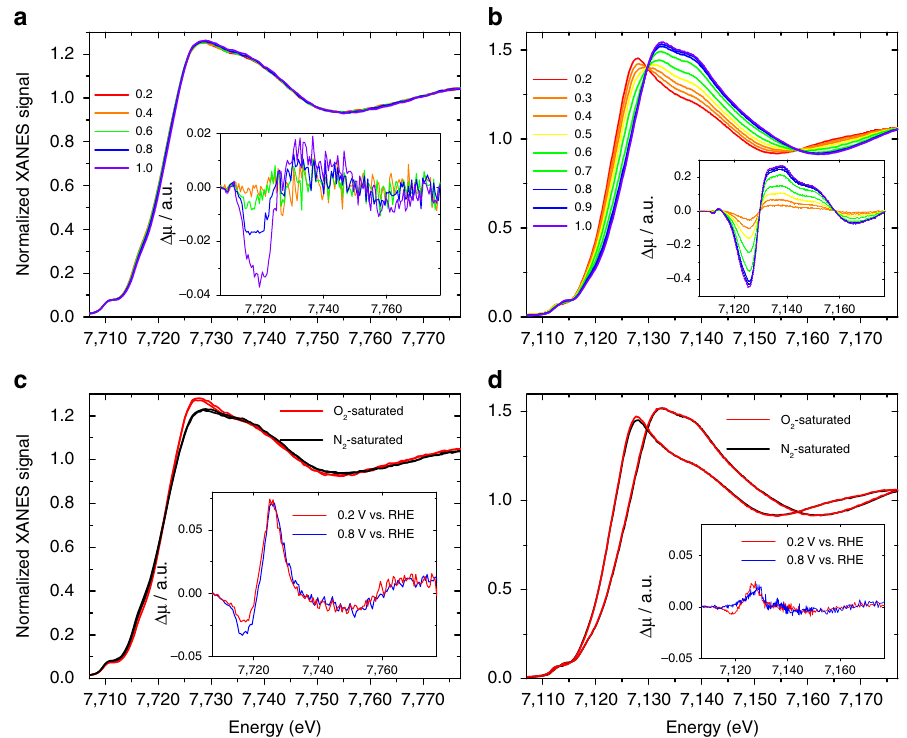
Fig. 4 Operando XANES spectra. Taken in 0.5 M H 2 SO 4 for Co 0.5 (left) and Fe 0.5 (right). The spectra were measured as a function of the electrochemical potential in N 2 -saturated electrolyte for a Co 0.5 and b Fe 0.5 (legend for potentials is in V vs RHE) and measured as a function of the saturating gas (O 2 or N 2 ) at either 0.2 V vs. RHE or 0.8 V vs. RHE for c Co 0.5 and d Fe 0.5 . Insets of a and b are differential Δ µ XANES spectra obtained by subtracting the normalized spectrum at every potential to the spectrum recorded at 0.2 V vs. RHE. Insets of c and d are Δ µ spectra obtained by subtracting the normalized XANES spectra recorded in O 2 - to that recorded in N 2 -saturated electrolyte, at a fi xed